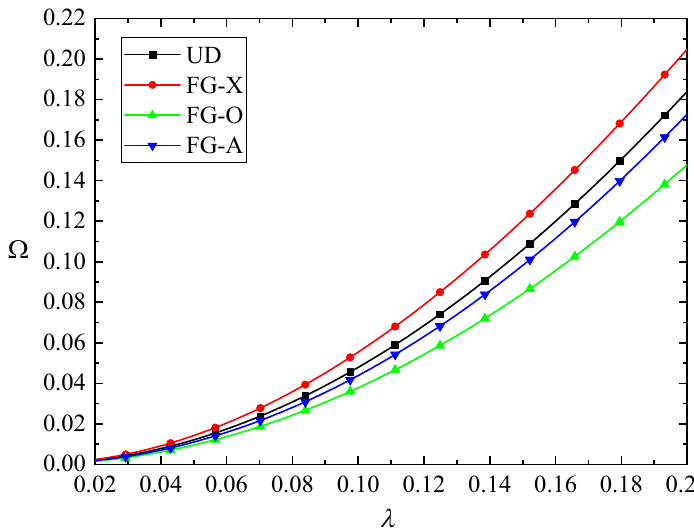
Figure 10. The fundamental frequency of S-S FG-GPLRC circular arch against thickness-to-radius ratio λ ( θ 0 = π/3).